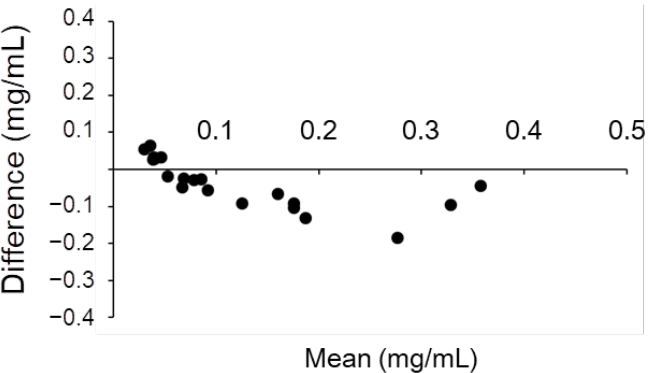
Figure 8. Bland–Altman plot of the values of immunoturbidimetry and the luciferin method after acetone precipitation. The horizontal axis represents the mean of the two methods, and the vertical axis represents the value of the luciferin method minus that of the immunoturbidimetric method.